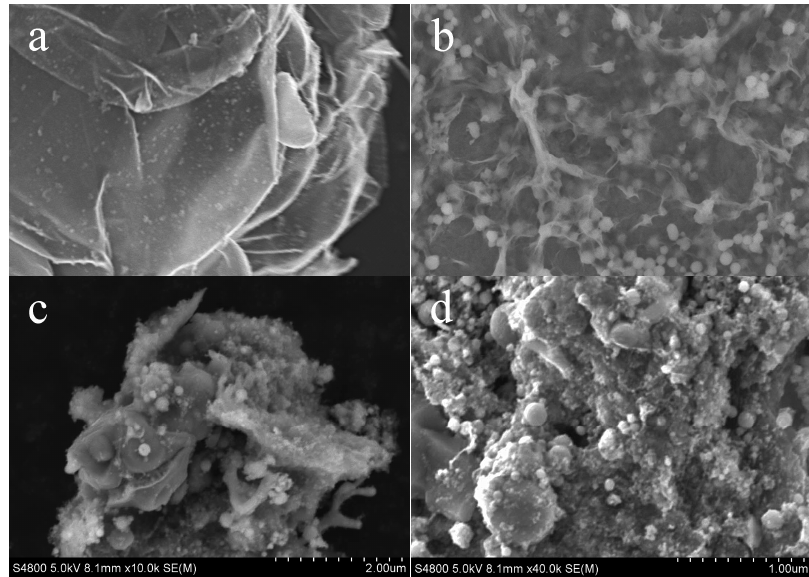
Figure 3. Typical scanning electron microscopy (SEM) images of the recovered samples. ( a ) Typical SEM image, ( b ) higher-magnification view of sample No. 1, ( c ) Typical SEM image, and ( d ) higher-magnification view of sample No. 3.